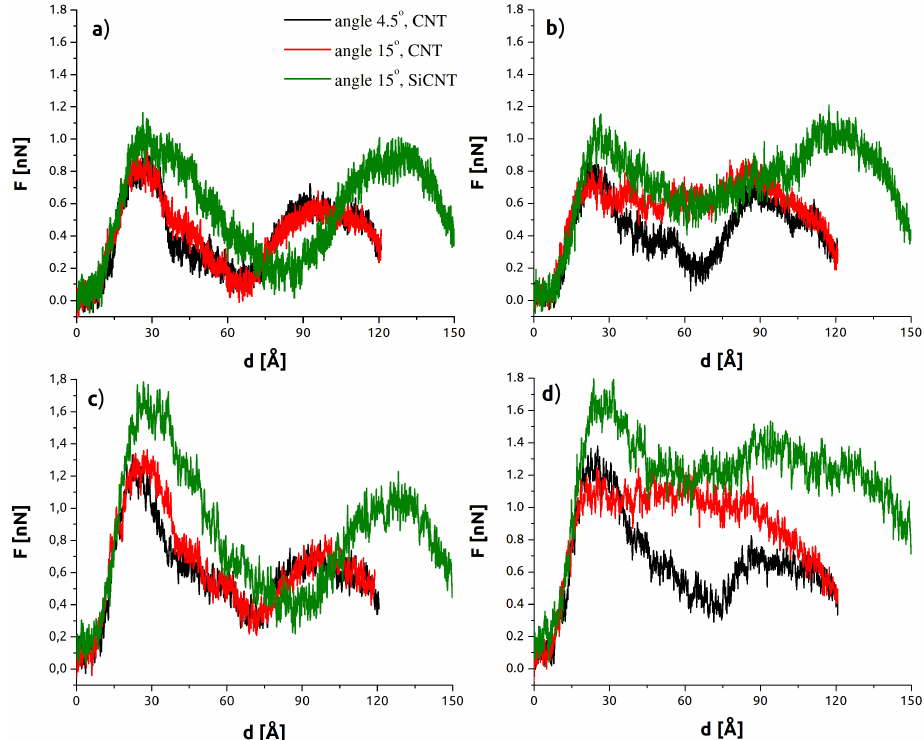
Figure 2. SMD force vs. indenter depth. ( a ) Low rate ( v = 0.5 m/s), tube-axis indentation. ( b ) Low rate ( v = 0.5 m/s), z -axis indentation. ( c ) High rate ( v = 2.0 m/s), tube-axis indentation. ( d ) High rate ( v = 2.0 m/s), z -axis indentation.